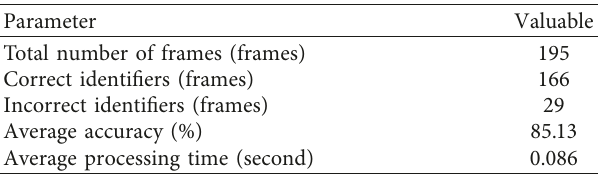
Table 3: Results of lane detection for different conditions with KITTI